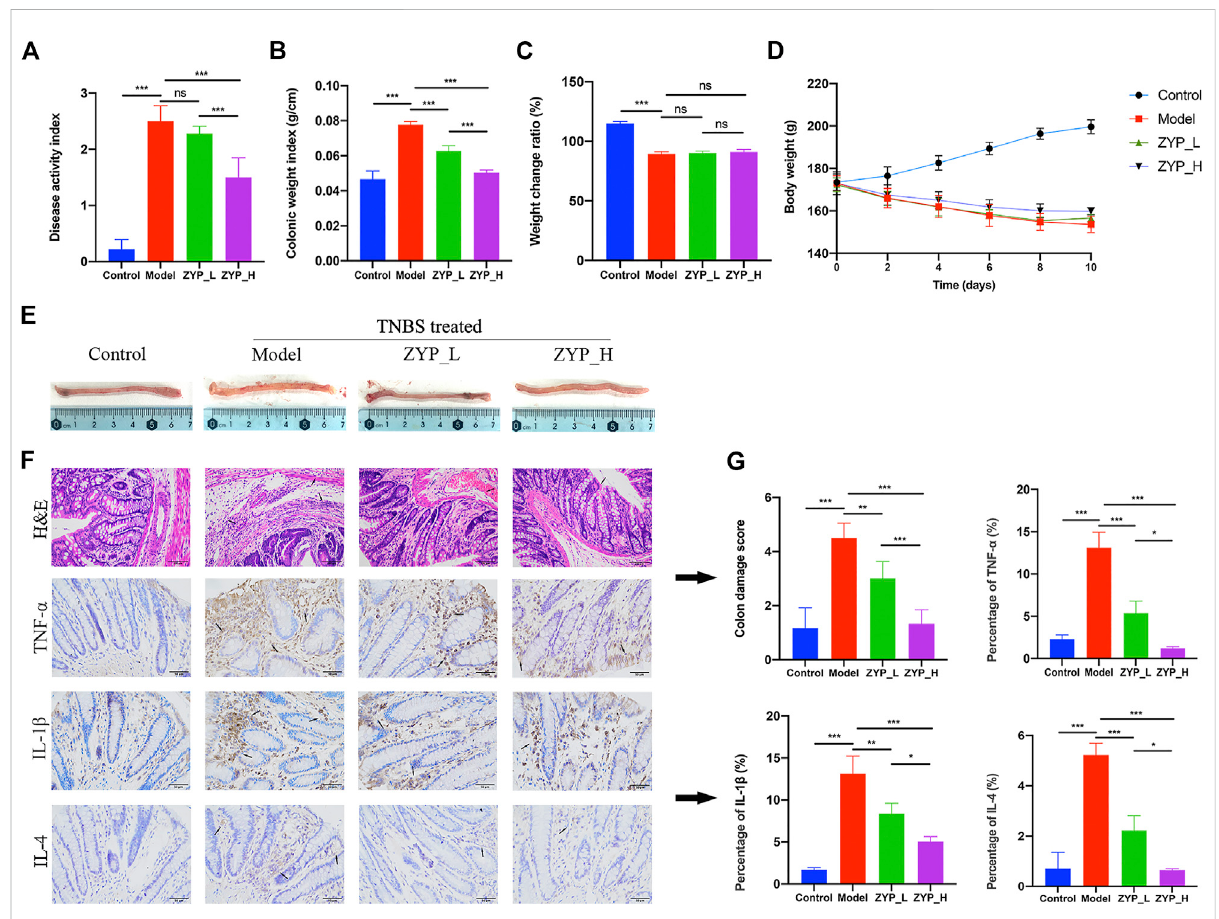
FIGURE 1 Evaluation of ZYP intervention effects. (A) DAI score; (B) Colonic weight index; (C) Weight change ratio; (D) Body weight change curves; (E) Colon phenotypes in the different groups; (F) Representative images of the H&E analysis and the TNF- α , IL-1 β , and IL-4 immunohistochemical analysis; (G) Colon damage score and proportion of the TNF- α , IL-1 β , and IL-4 cells in the four groups. Data are means ± SD, n = 6. ***/**/*, p < 0.001/ p < 0.01/ p < 0.05; ns, not signi fi